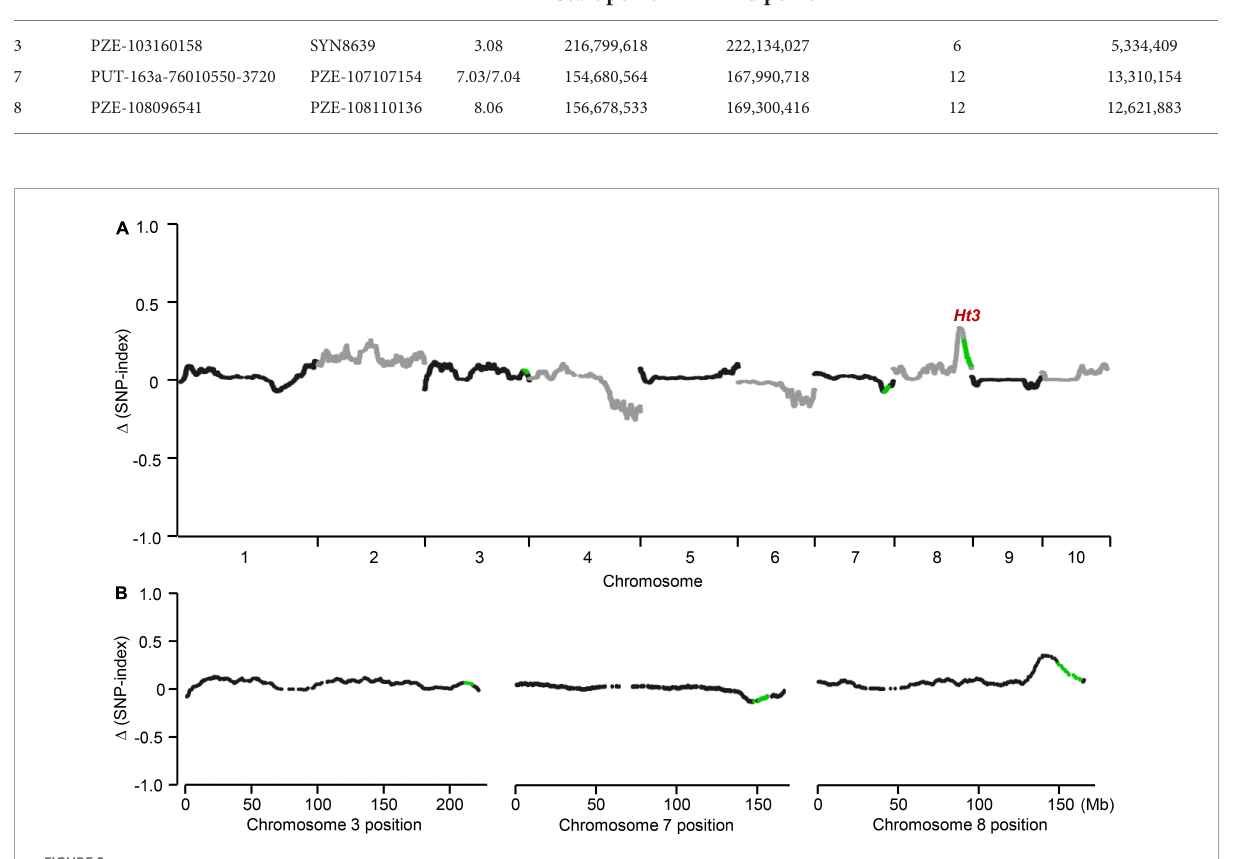
FIGURE2 Initial detection of the Ht3L locus. In the BC 2 F 1 segregating population, highly resistant and susceptible individuals were selected to prepare two blocks. SNP-index value which represents the heterozygosity was estimated for each SNP. (A) Genome-wide association mapping of Ht3L locus. (B) Ht3L was located in bin 8.06. Difference in SNP-index between two bulks, (cid:49) (SNP-index), was calculated for all SNPs and used for genome-wide association. The average (cid:49) (SNP-index) was calculated using a sliding window analysis with 10-Mb window size and 10-kb increments. Each plot represents a SNP marker, and the green plots correspond to the significantly associated SNPs in NILs analysis. The Ht3L locus was identified as a peak of the (cid:49) (SNP-index) in bin